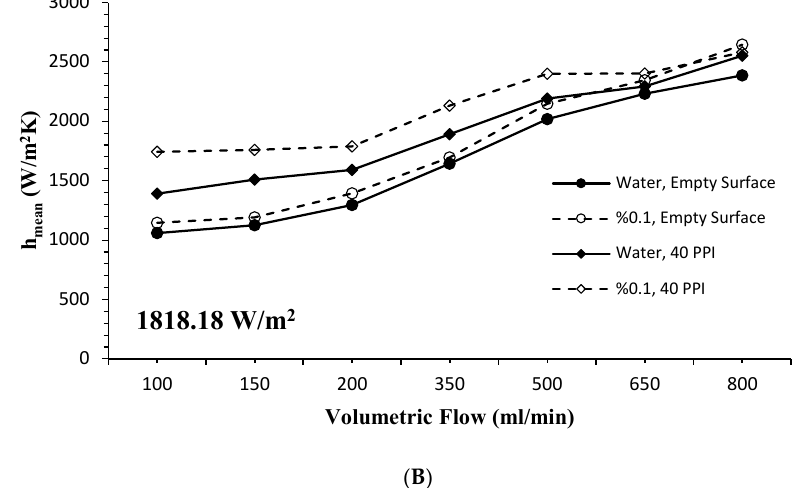
Figure 7. Variation of mean convective heat transfer coefficient with volume flow rate at 1818.18 W/m 2 ( A ) 10 PPI; ( B ) 40 PPI.